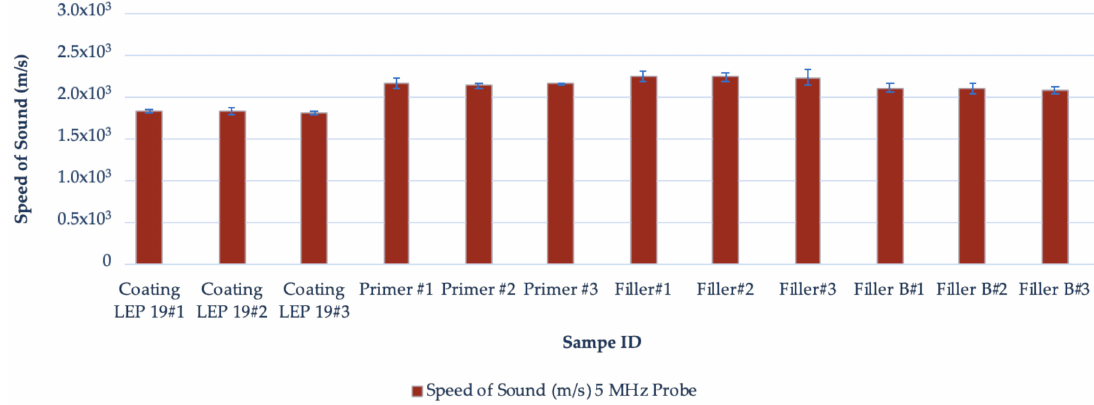
Figure 4. Average Speed of Sound measurements with the 5 MHz probe.